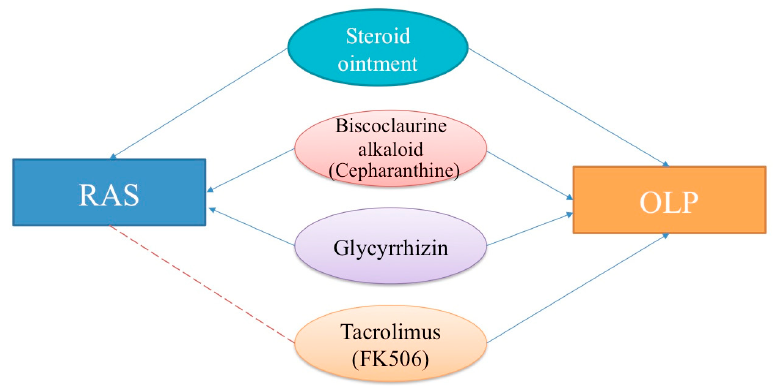
Figure 4. Therapeutic topical and systemic agents for recurrent aphthous stomatitis (RAS) and oral lichen planus (OLP). Blue lines with arrowheads: effective. Red dashed lines: probably effective.